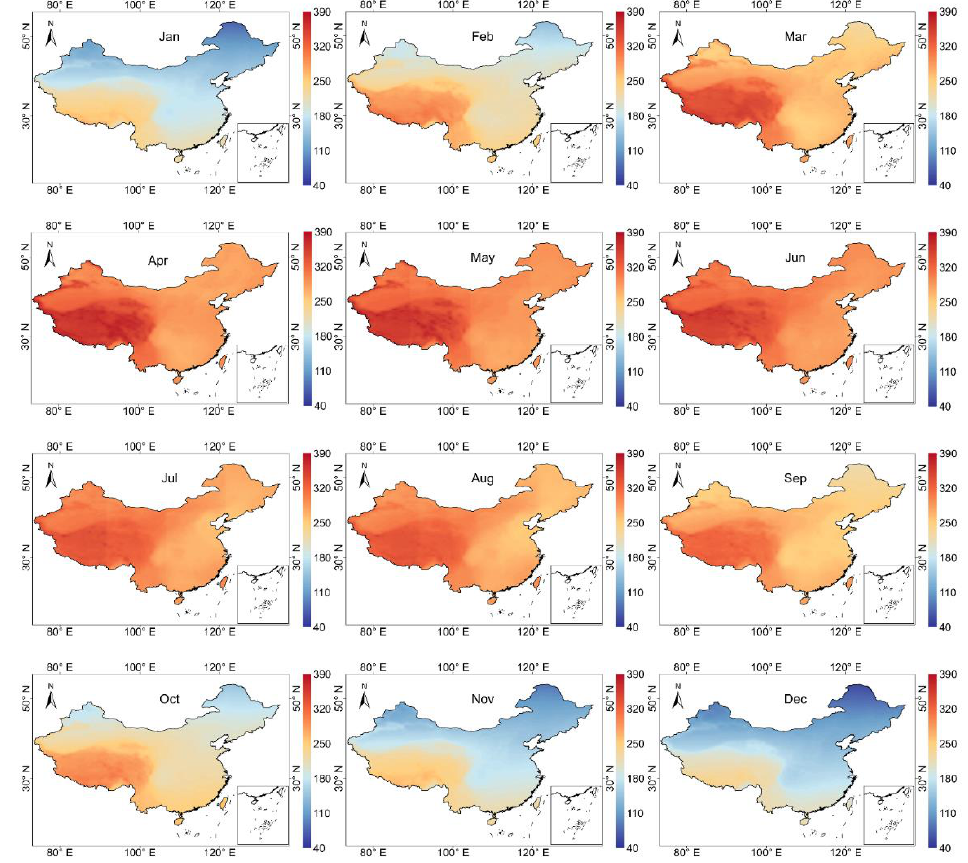
Figure 5. Spatial distribution of the total monthly mean POAI (Wm − 2 ) under clear-sky conditions in China from 2010 to 2020.